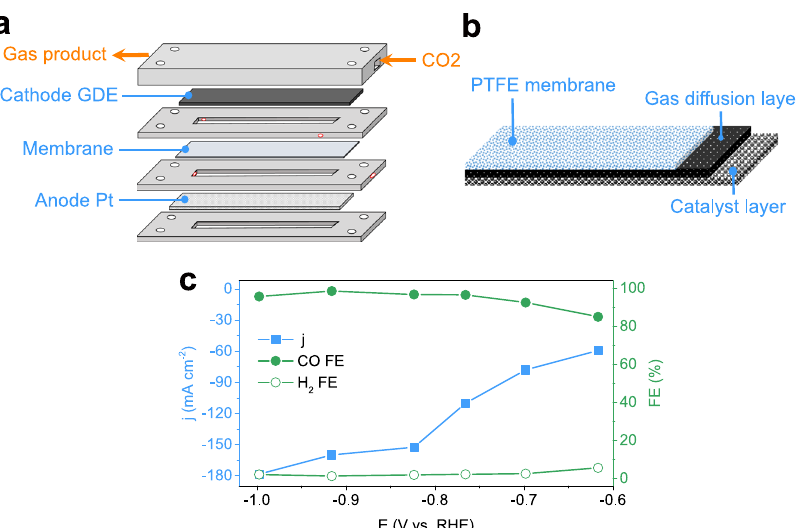
Fig. 4 Electrochemical experiments in a fl ow-cell system. Schematic illustration of a micro fl uidic fl ow cell and b cathode GDE. c Total current density (blue) and FE of CO (green solid dots) and H 2 (green hollow dots) as a result of controlling